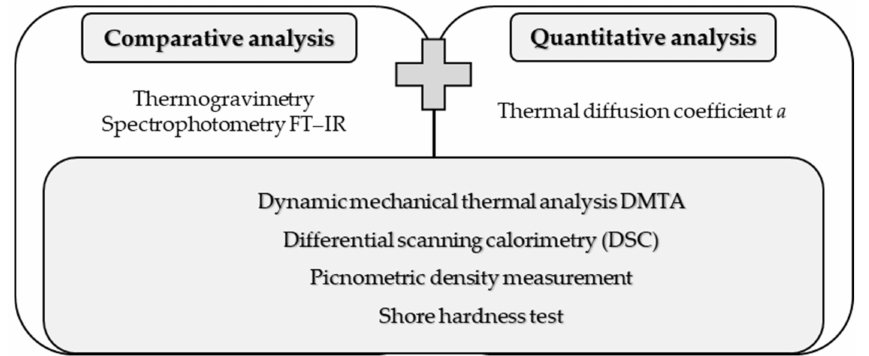
Figure 2. Classification of performed